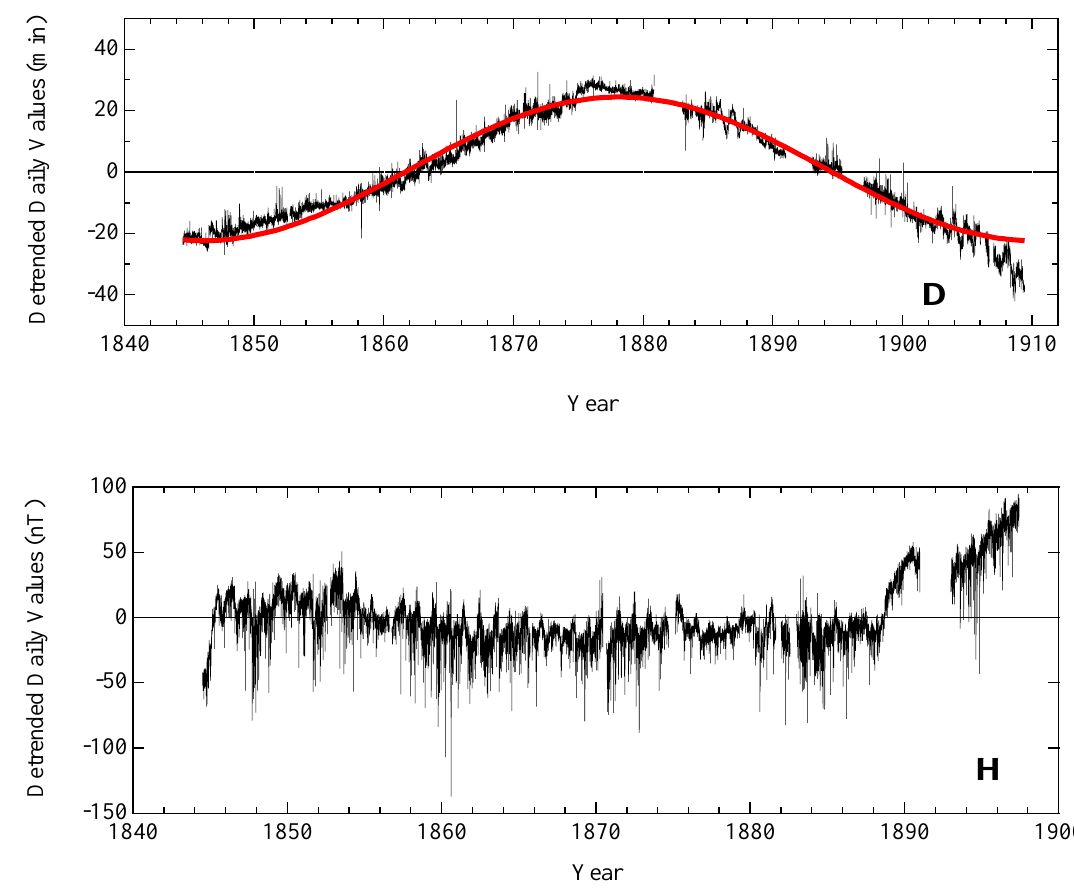
Fig. 2 Fig. 2. Daily residuals of D (upper panel) and H (lower panel) after removal of the long-term trend. The observed values of H were not absolute and thus their long-term trend (an exponential decay) does not represent any true secular variation but rather slow changes in the variometer instrument itself. In 1D , the long-term linear trend (see Fig. 1) is a signature of the real secular variation. A smoothly varying quasi-sinusoidal secular variation component (see, Eq. 1) is shown by the red curve. 1D is converted to nT-unit by multiplying it by